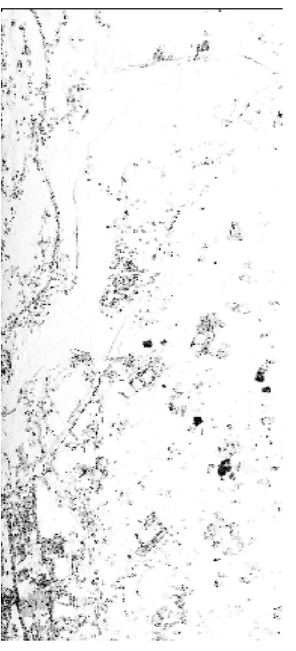
Figure 5. Coherence coefficient map